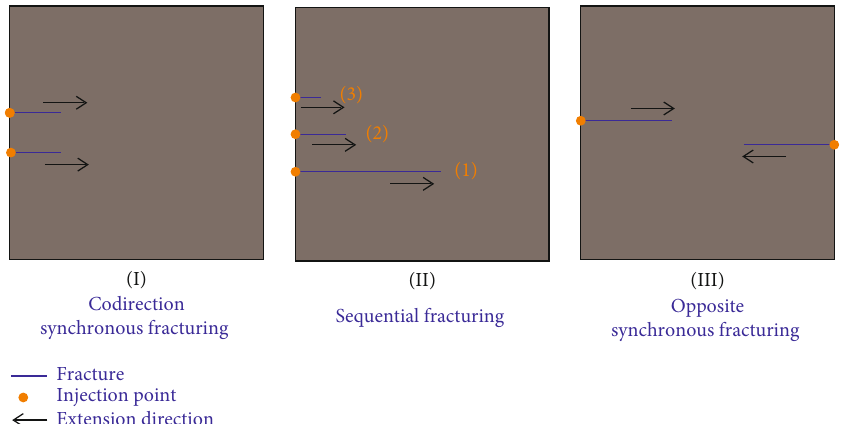
Figure 8: Examples of the three types of crack